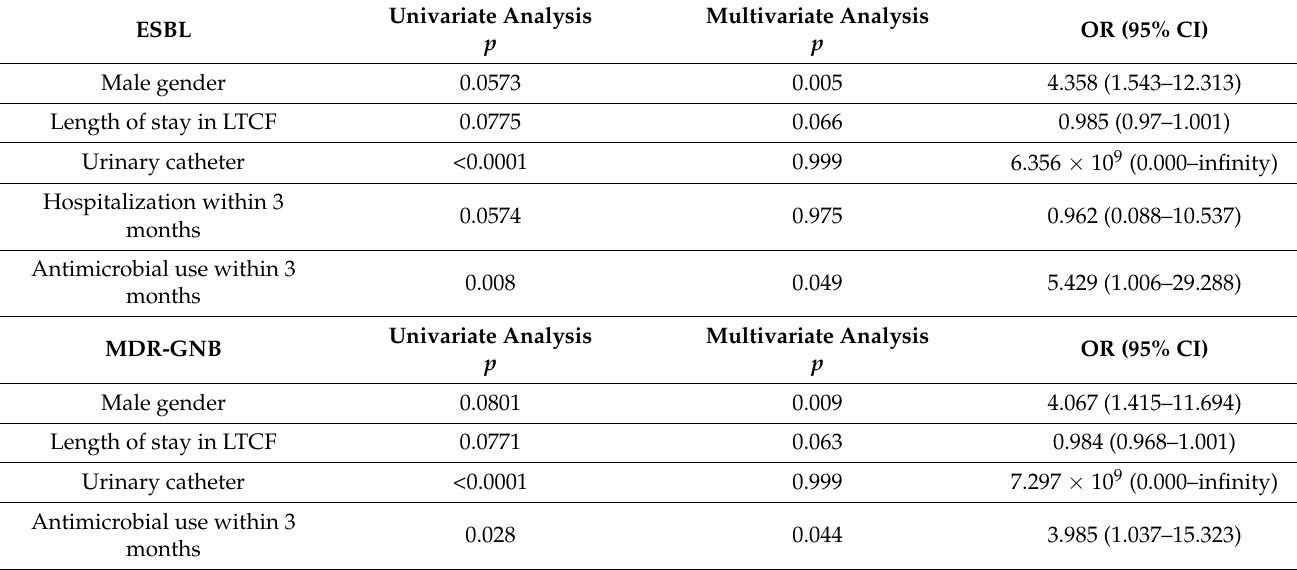
Table 6. Regression analysis of colonization of LTCF residents by ESBL-producing microorganisms or MDR-GNB.